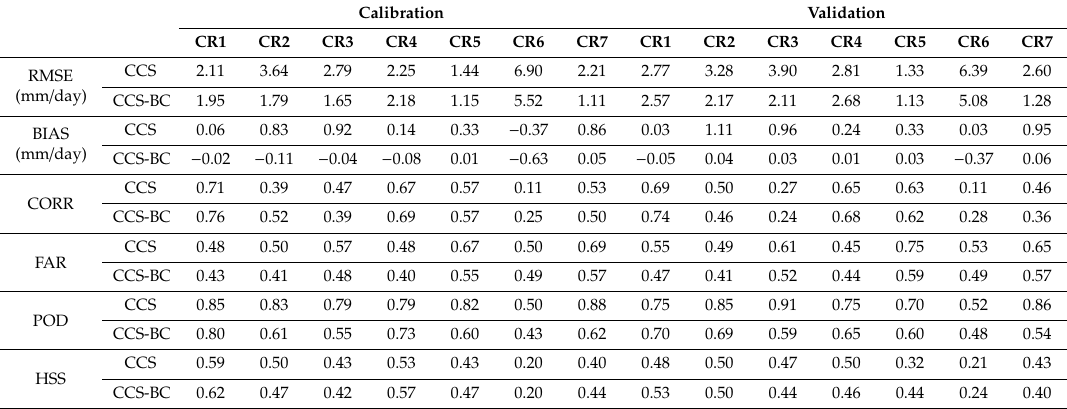
Table 4. The quantitative and categorical statistic results of the daily evaluations of the areal mean for the CCS and CCS-BC compared to the gauge observations for the seven CRs for the calibration (2009–2016) and validation (2017–2018) periods. Calibration